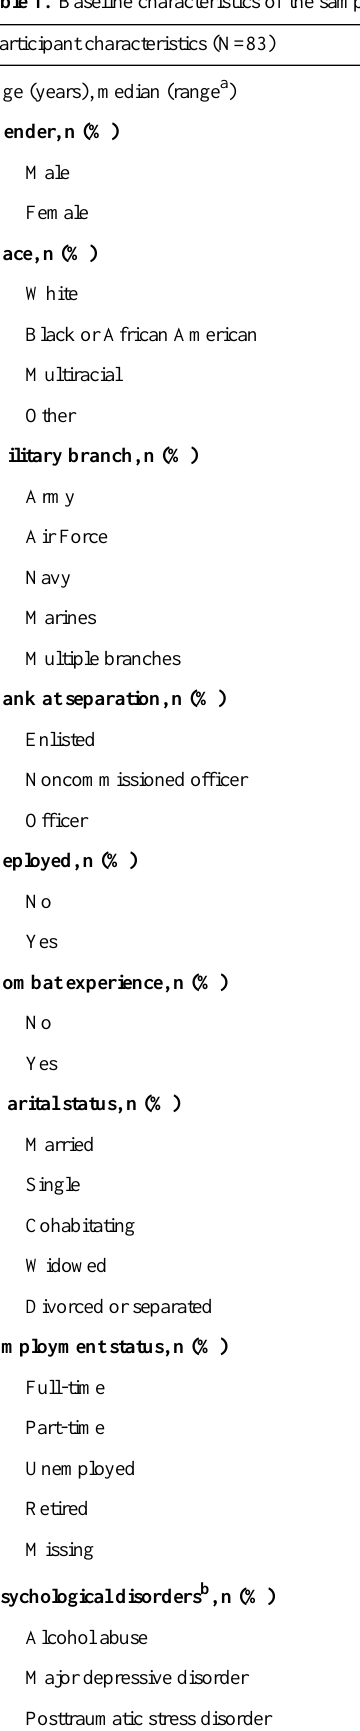
Table 1. Baseline characteristics of the